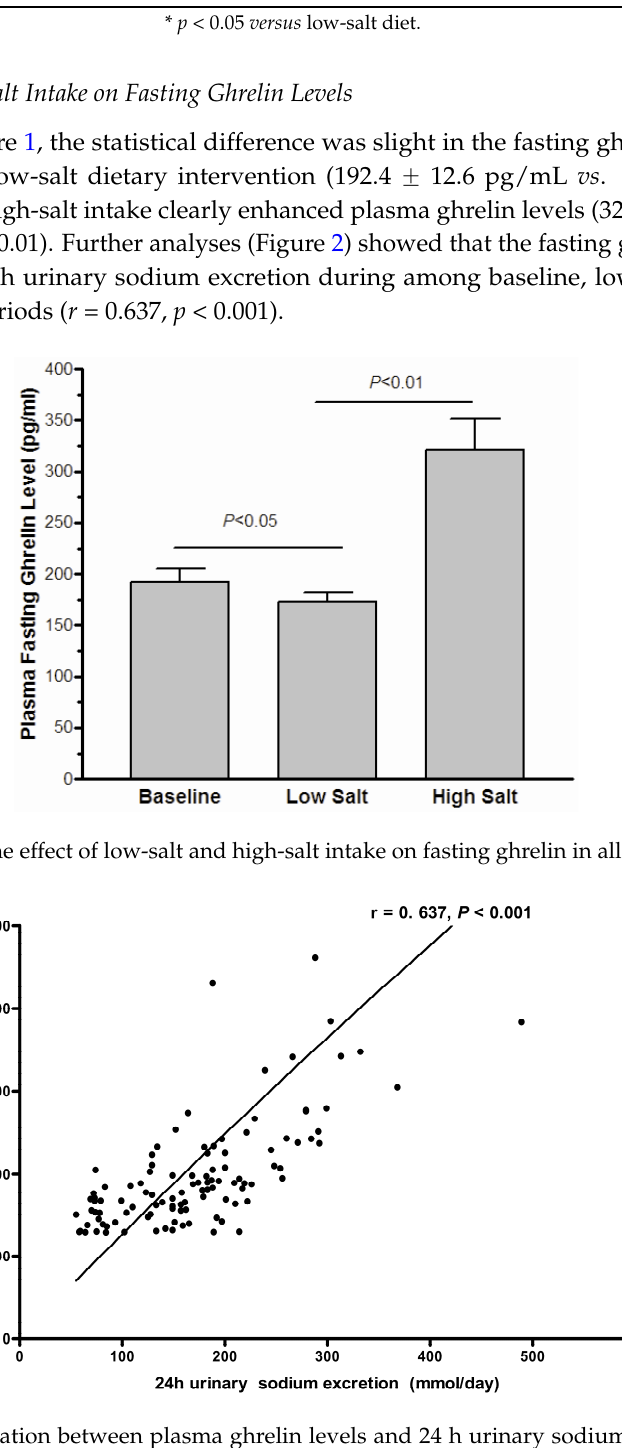
Table 2. BP Levels (mmHg) and 24-h Urinary Sodium (mmol/day) at Baseline and During Dietary Interventions.